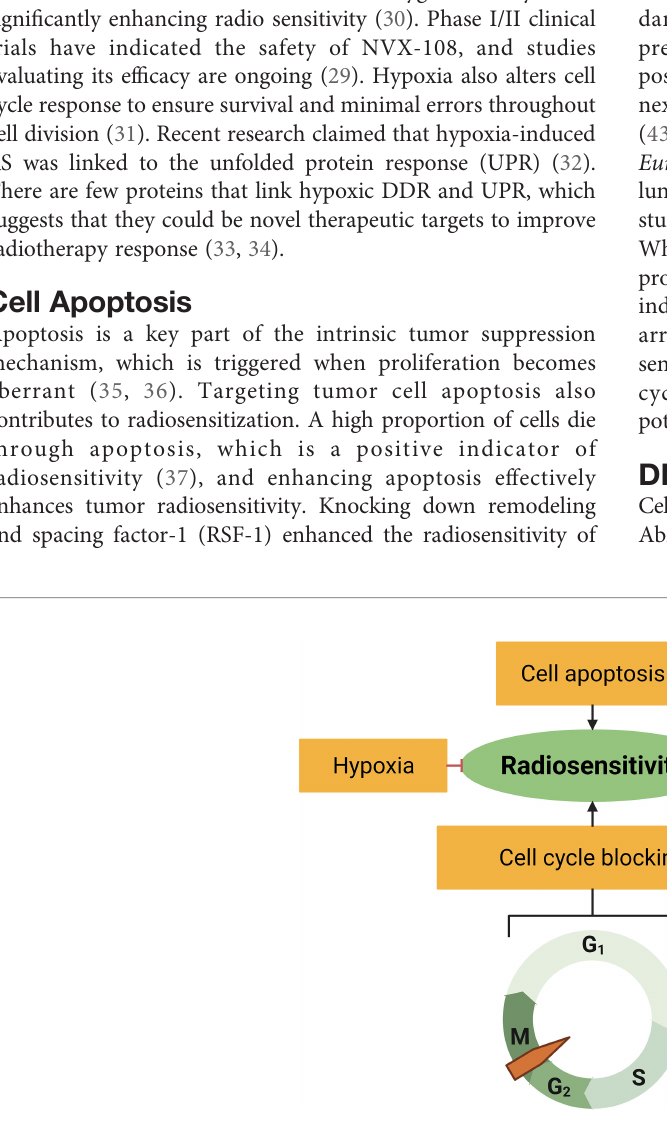
FIGURE 3 | Radiosensitivity is associated with hypoxia, cell apoptosis, cell cycle distribution, and DNA damage